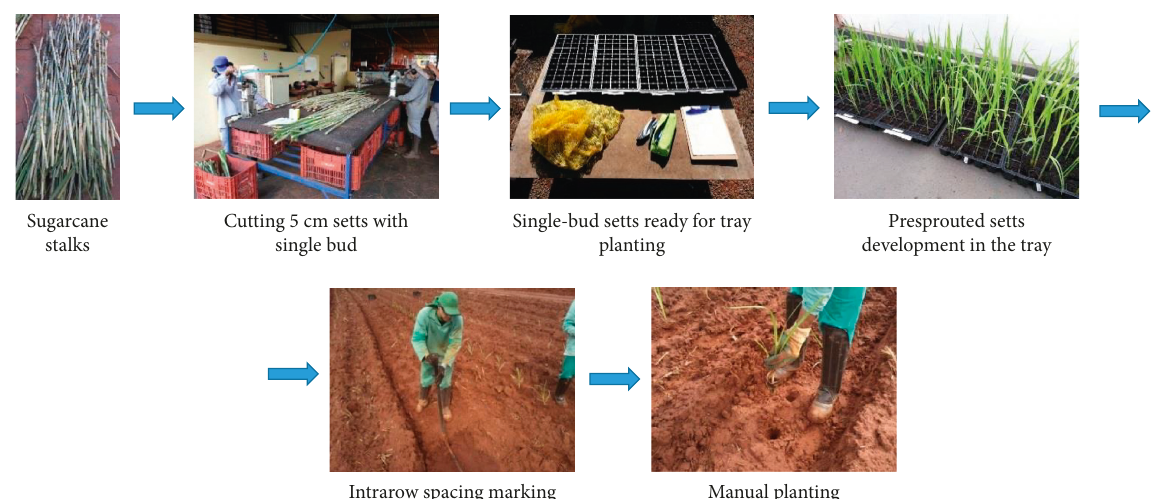
Figure 2: Process for MPB (presprouted seedling) production and planting.